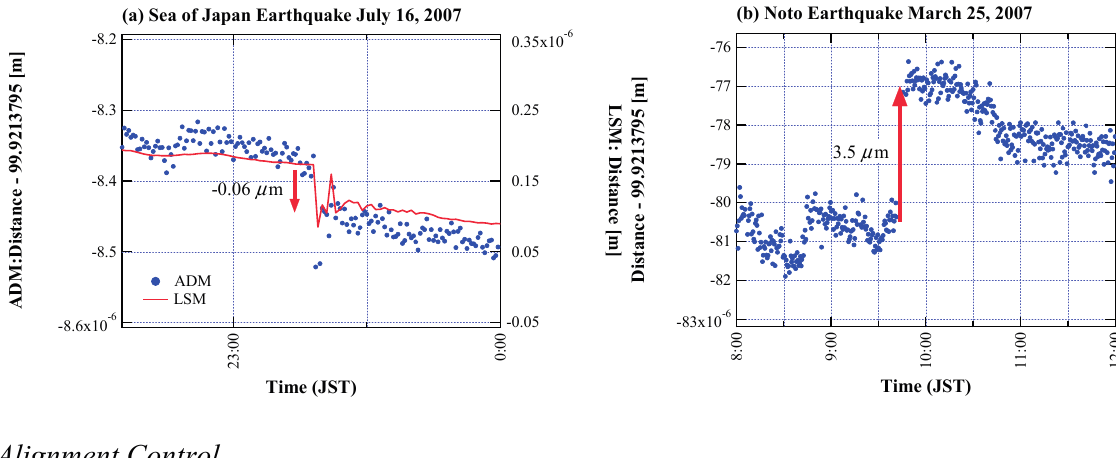
Figure 8. Strain steps caused by earthquakes observed at the Kamioka site. ( a ) A relatively small change in distance close to the ADM resolution was observed for the small earthquake. Results were confirmed by the co-located LSM based on the standard Michelson interferometer with better resolution. ( b ) A large step was caused by the nearby and large earthquake. The LSM failed to track this step, because of fringe miscounting. The contribution of Earth’s tide has been simulated and removed from the observed data in both plots. A detailed analysis of these events is described in our earlier publication